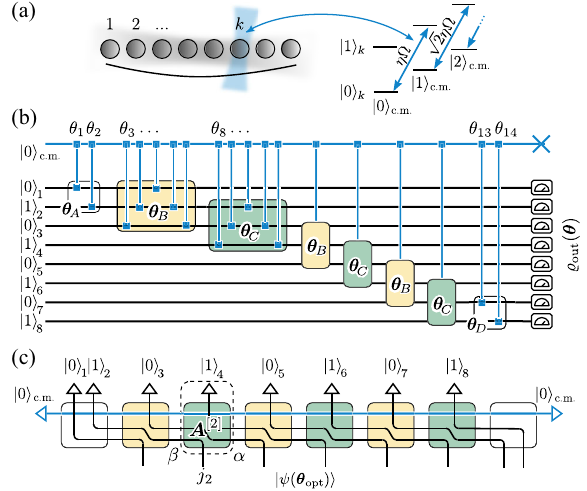
FIG. 1. Scheme of the TN VQE realized on a string of eight ions. (a) The logical states j 0 i k and j 1 i k are encoded in electronic levels of ion k . j i i are the basis states of the bosonic axial c : m : center-of-mass (c.m.) phonon mode. We implement entangling operations (vertical blue lines) between a single qubit and the c.m. mode (blue horizontal line). (b) TN variational circuit built with blue-sideband operations as the only resource. (c) The resulting optimized many-body quantum state expressed in the graphical notation of tensor networks, which clearly highlights the bipartite entanglement distribution of a matrix product state. The empty triangles indicate contraction with pure single-qubit states written nearby. The dashed rounded rectangle indicates 2 (cid:2) tensor A ½ j 2 ; α ; β , which is given by Eq. (5).